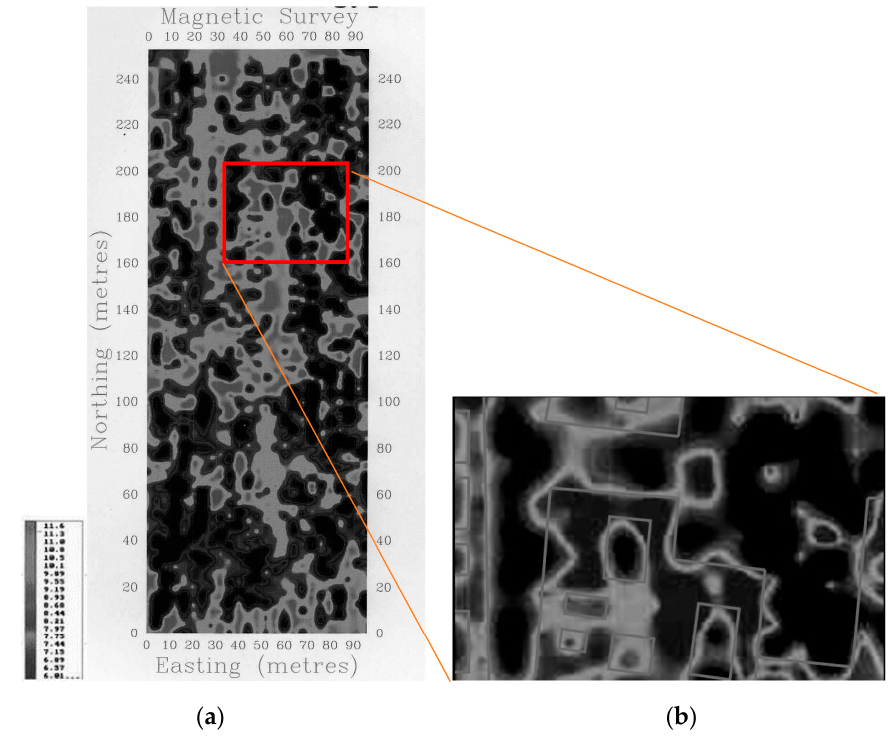
Figure 5. ( a ) Partial results from the 2003 magnetometer survey of Tell Tebilla indicating buried mudbrick from a housing/cemetery installation, with detail of inset; ( b ) Shows the location of the mudbrick walls Imagery courtesy Larry Pavlish and Greg Mumford.